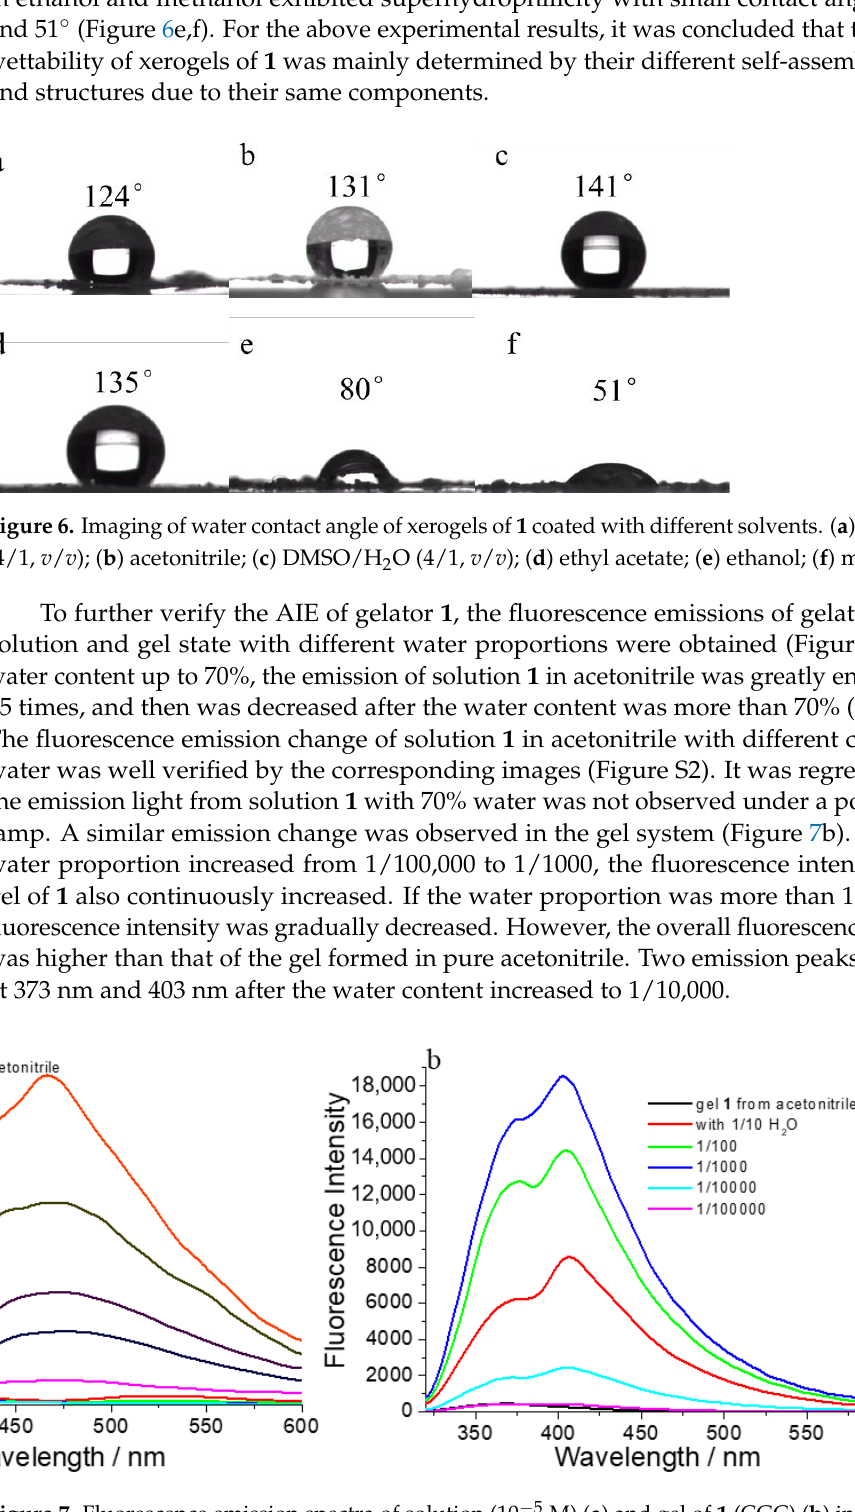
Figure 5. FT IR spectra of xerogels of 1 in different solvents and powder 1 .